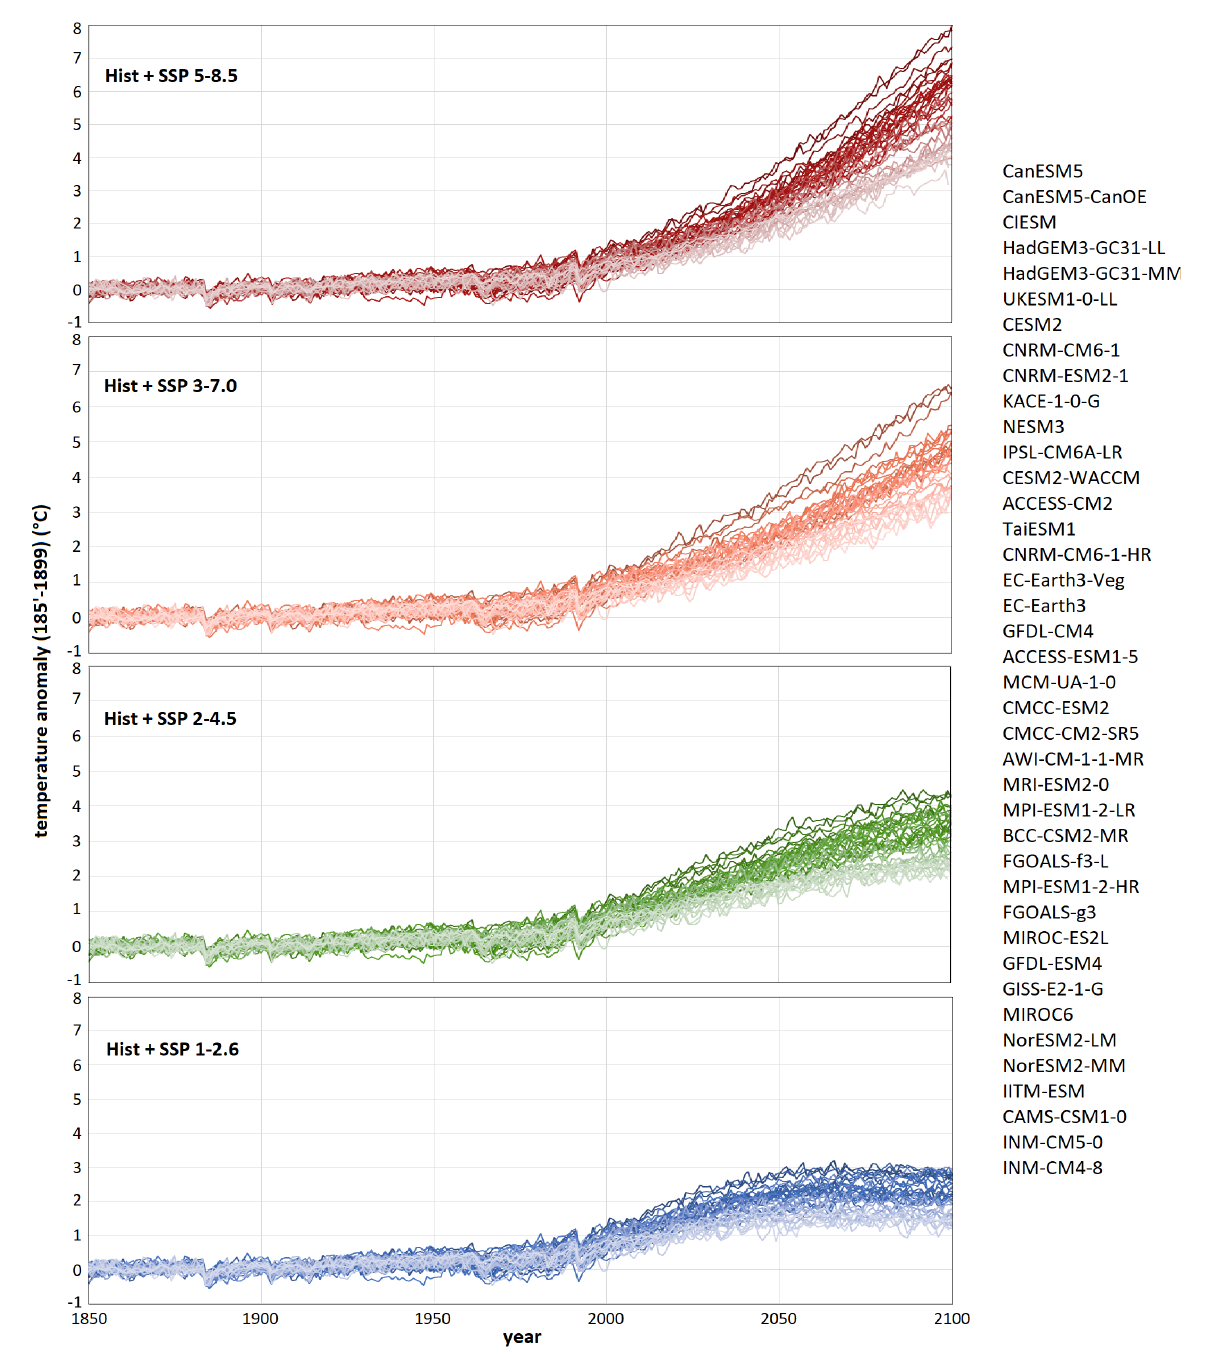
Figure 1. Surface air temperature (tas) simulations of the CMIP6 Global Circulation Models (GCMs) using historical + SSP forcing functions. The GCM list and the color gradients of the curves go from low-ECS (light color) to high-ECS (dark color). See Table A1 and Supplementary